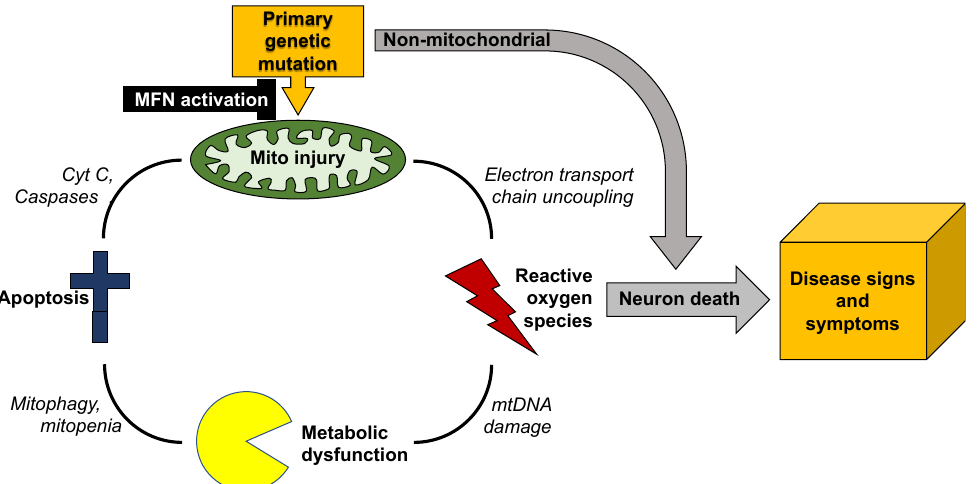
Figure 3. Vicious cycle of mitochondrial degeneration in neurodegenerative diseases . Any primary or secondary mitochondrial injury will tend to accelerate mitochondrial degeneration, culminating in neuronal death and neuromuscular dysfunction. Mitofusin (MFN) activation can provide resistance to injury through reparative fusion, potentially interrupting cycle.